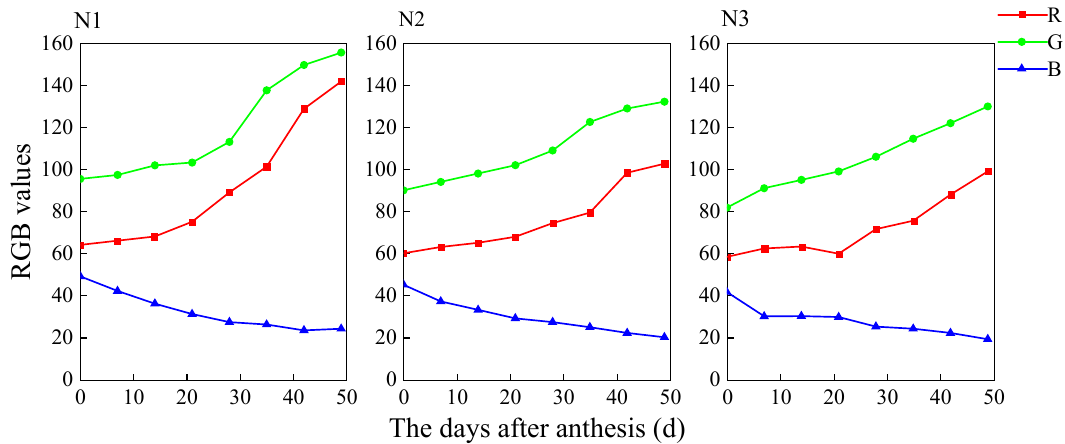
Figure 3. Dynamic changes in leaf RGB values with high, medium, or low nitrogen supplies in YJ4227 after anthesis.